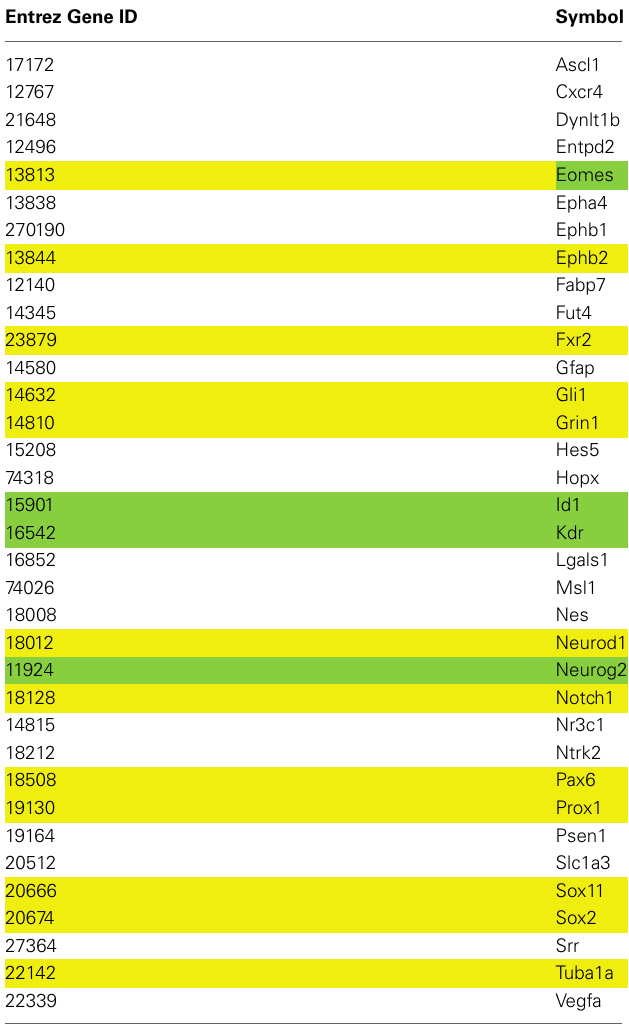
Table 3 | List of MANGO genes expressed in Nestin positive cells. Entrez Gene